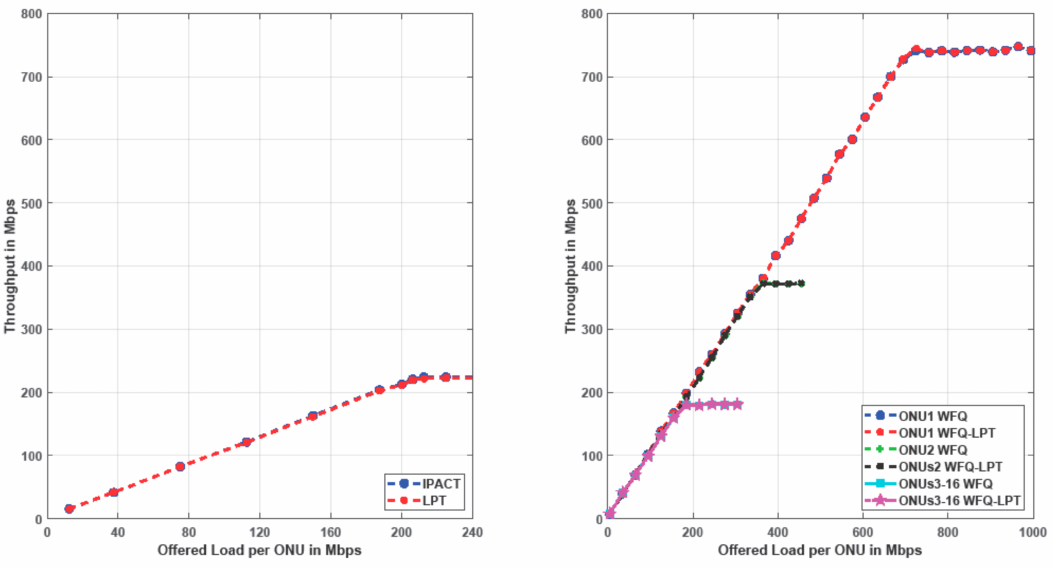
Figure 2. Throughput for all 16 ONUs at LTT = 0 µ s; IPACT vs. LPT ( left ) and WFQ vs. WFQLPT ( right ).